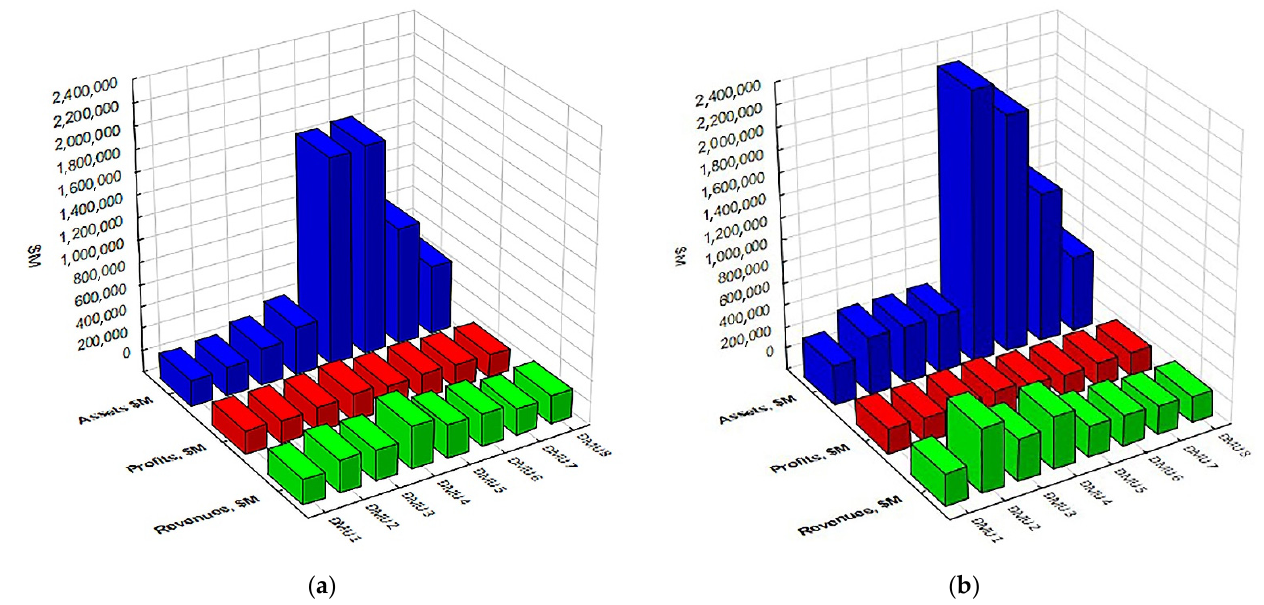
Figure 1. Characteristics of DMU in terms of revenues, profits and assets for 2015 and 2021 (USD millions). Source: calculated by the authors based on the data [59–83]. ( a )—2015; ( b )—2021.